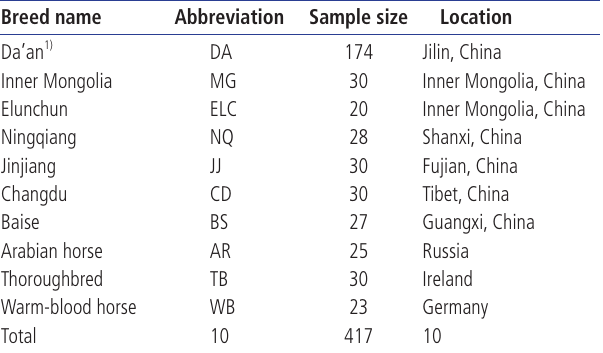
Table 1. The location and breed information of the 417